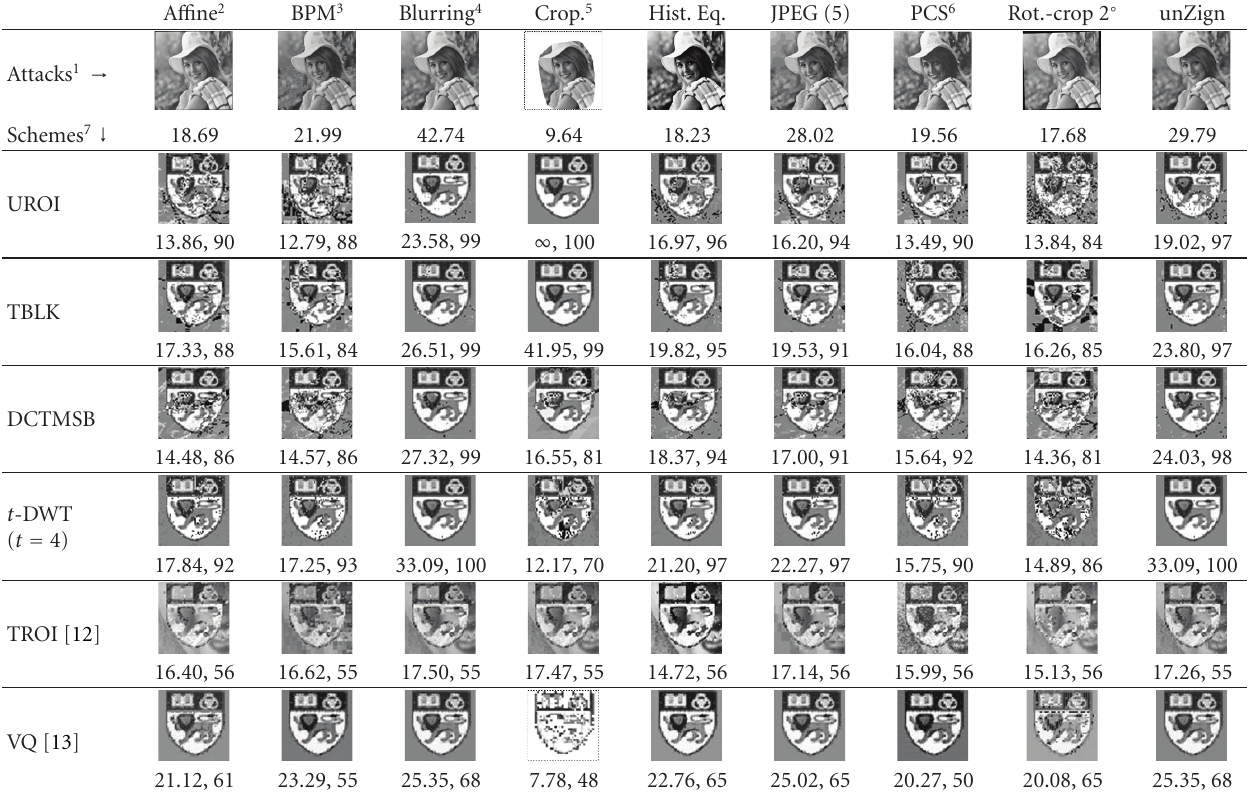
logo against di ff erent JPEG quality factors. Figure 5(a) and Figure 5(b) plot the same using Elaine image and NUS